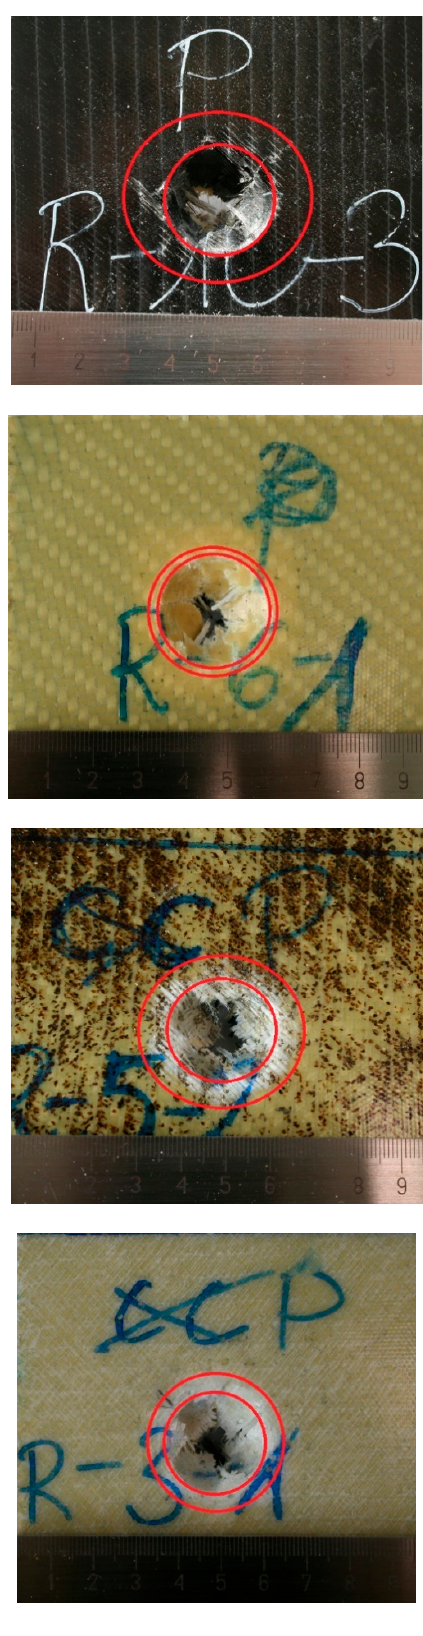
Figure 5. Photographs of impacted laminates GCABF ( a ), CGABF ( b ), CAGBF ( c ), MAGCBF ( d ), VGACBF ( e ), MGACBSF ( f ) with various damage modes.